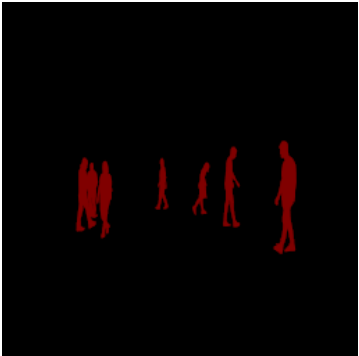
Figure 17. The image represents the ground truth where the pedestrians are shown in red.